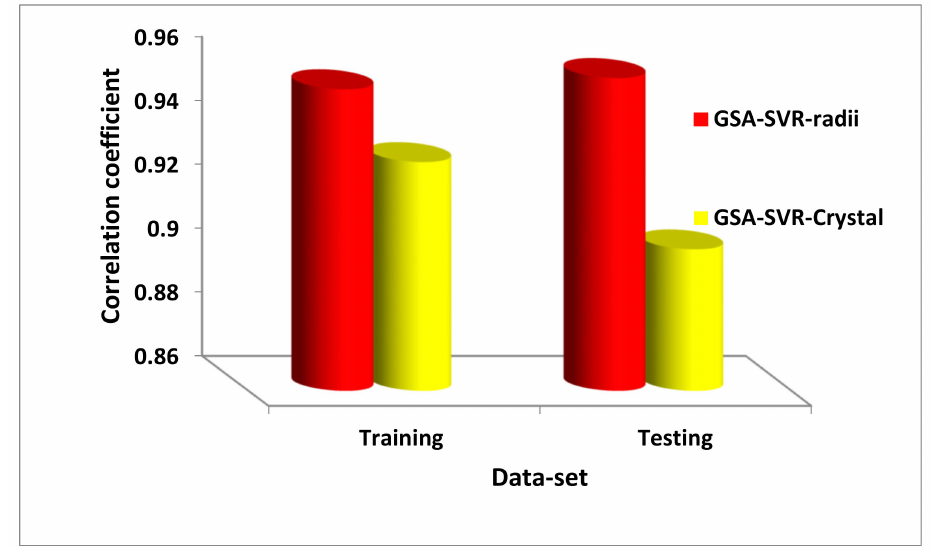
Figure 3. Comparison between the GSA-SVR-radii and GSA-SVR-Crystal models on the basis of the correlation coe ffi